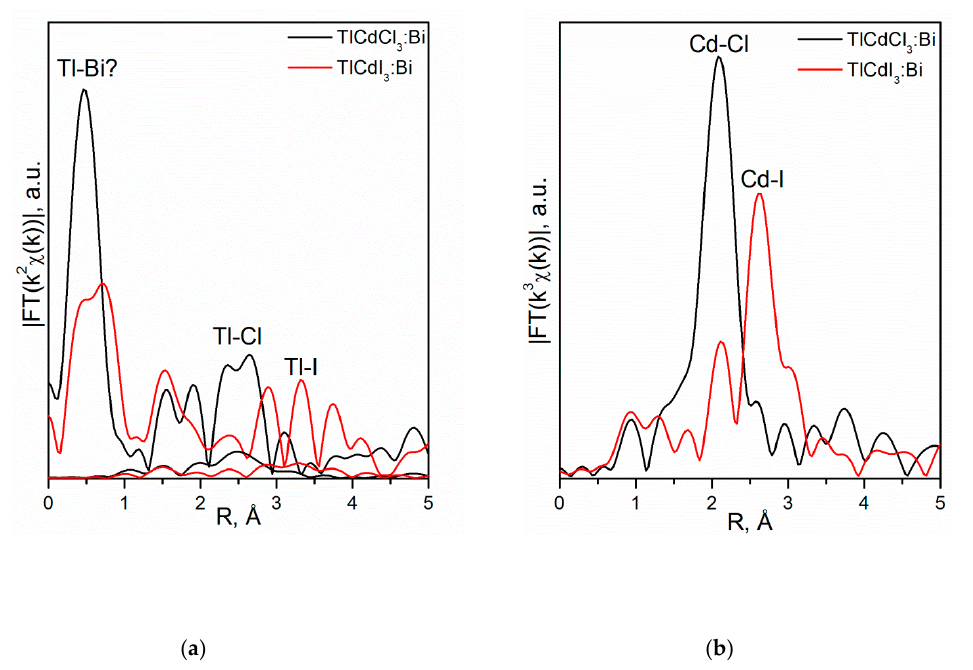
Figure 18. EXAFS Fourier transform curves measured ( a ) at the Tl L 3 -edge and ( b ) at the Cd K-edge